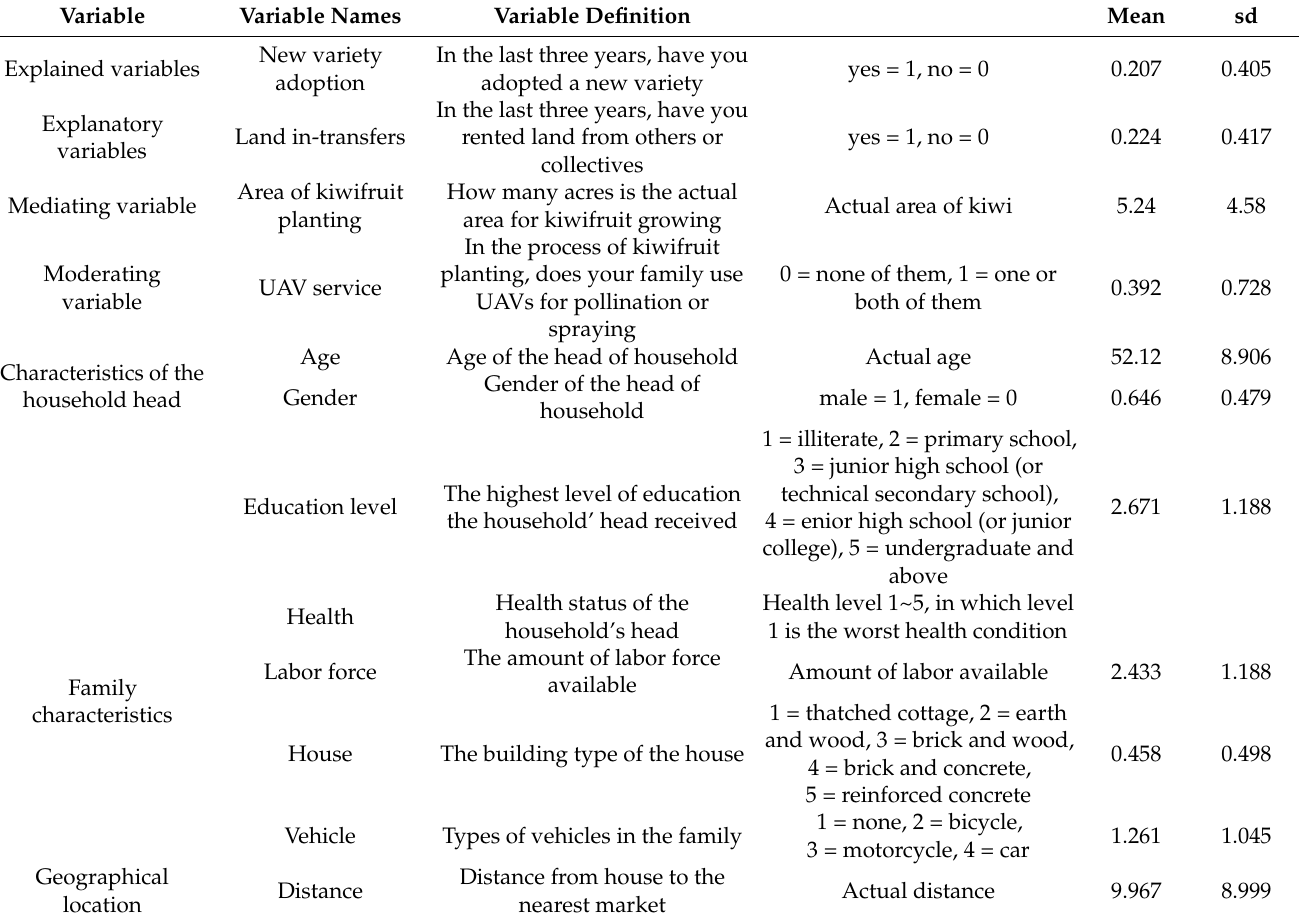
Table 1. Distribution of